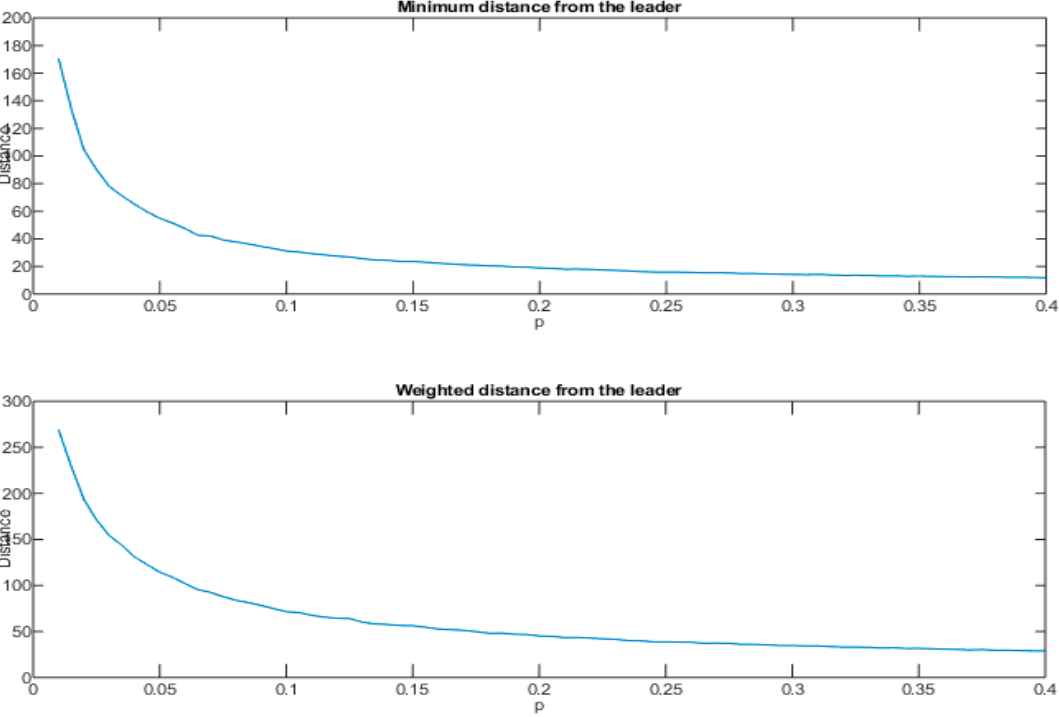
Figure 5. Starting from the plot on top, Minimum normalized distance and Weighted normalized distance of the small-world model in function of p .